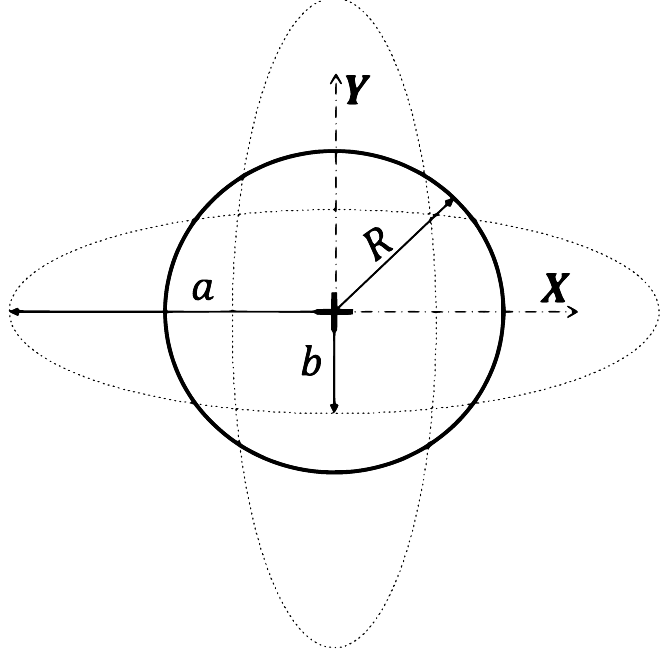
Figure 5. Oscillating droplet under a central conservative force field. R is the raduis of the intial circular drop, a and b are the semi-major and semi-minor axis of the evolving ellipse,